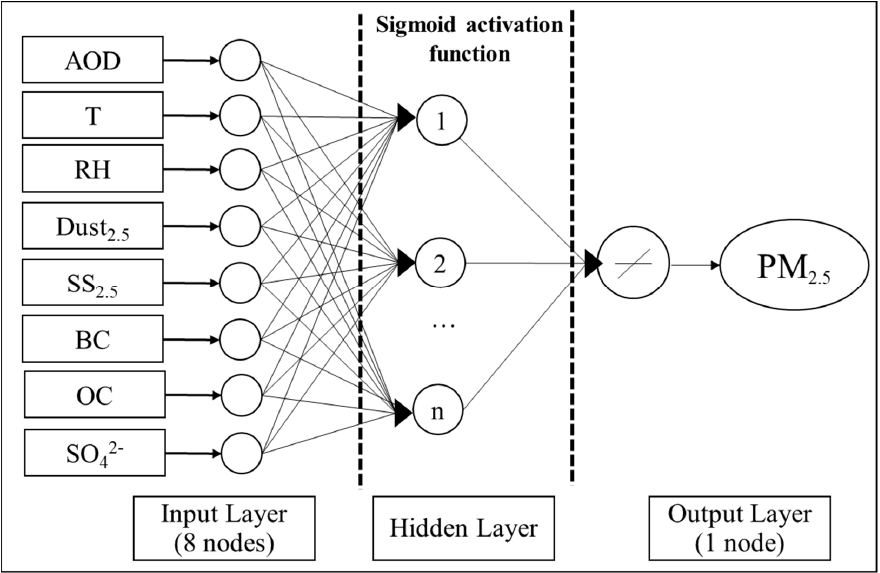
Figure 3. A schematic of the NN model used in this study to estimate PM 2.5.